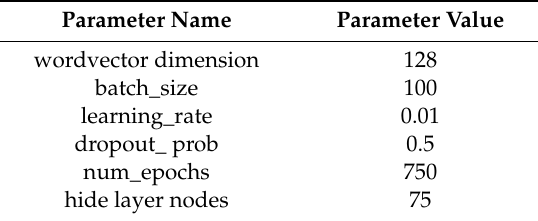
Table 6. Experimental